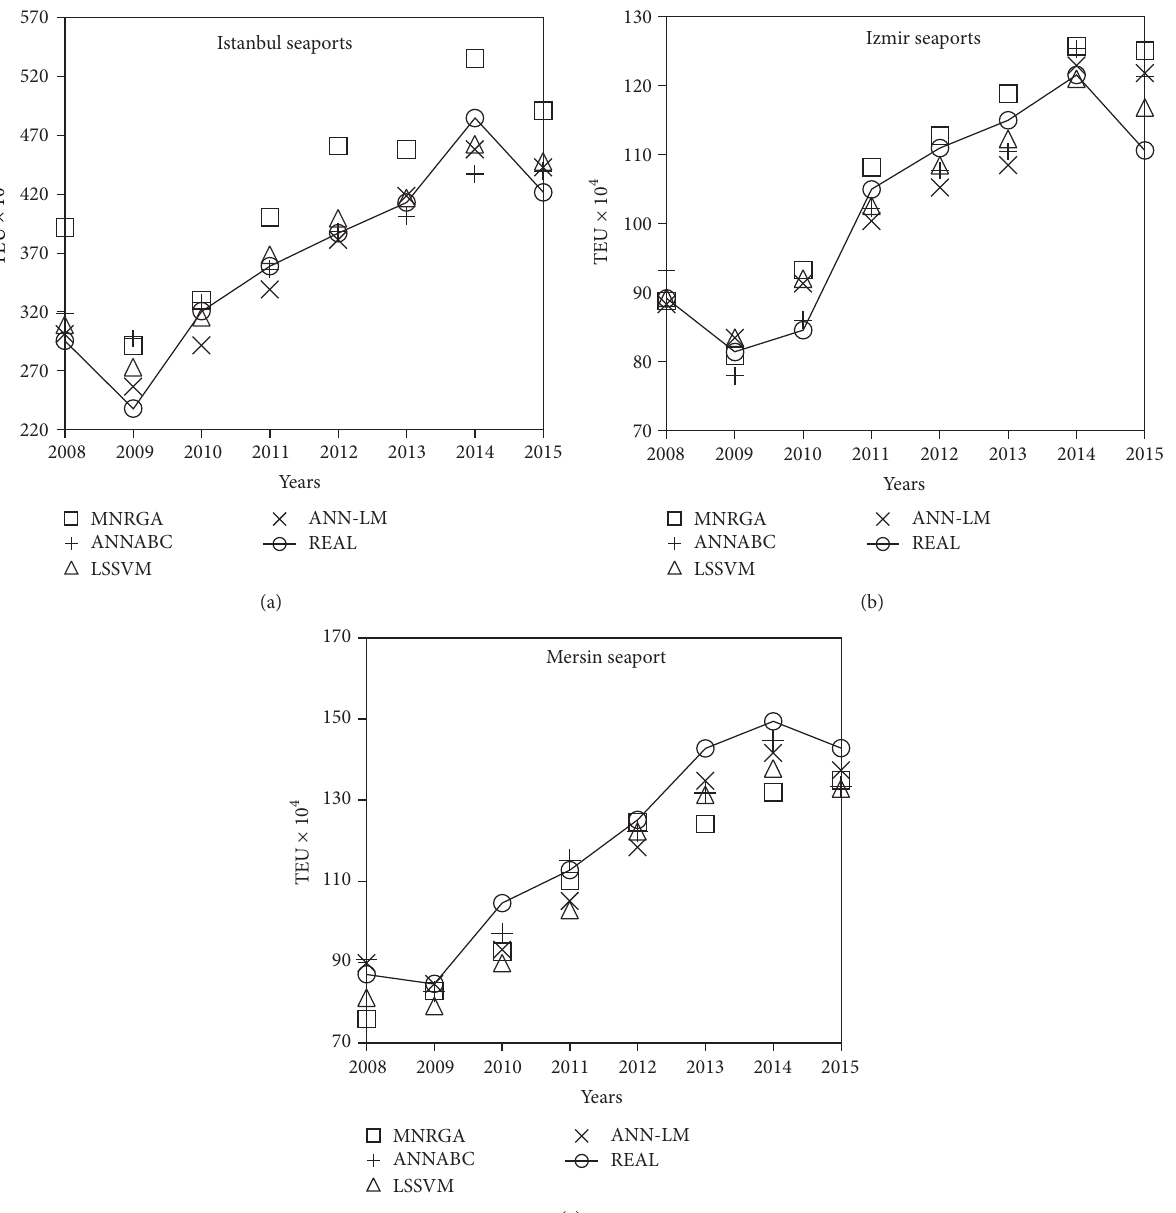
Figure 5: Time plots of the forecasts for the testing period (a) Istanbul, (b) Izmir, and (c) Mersin